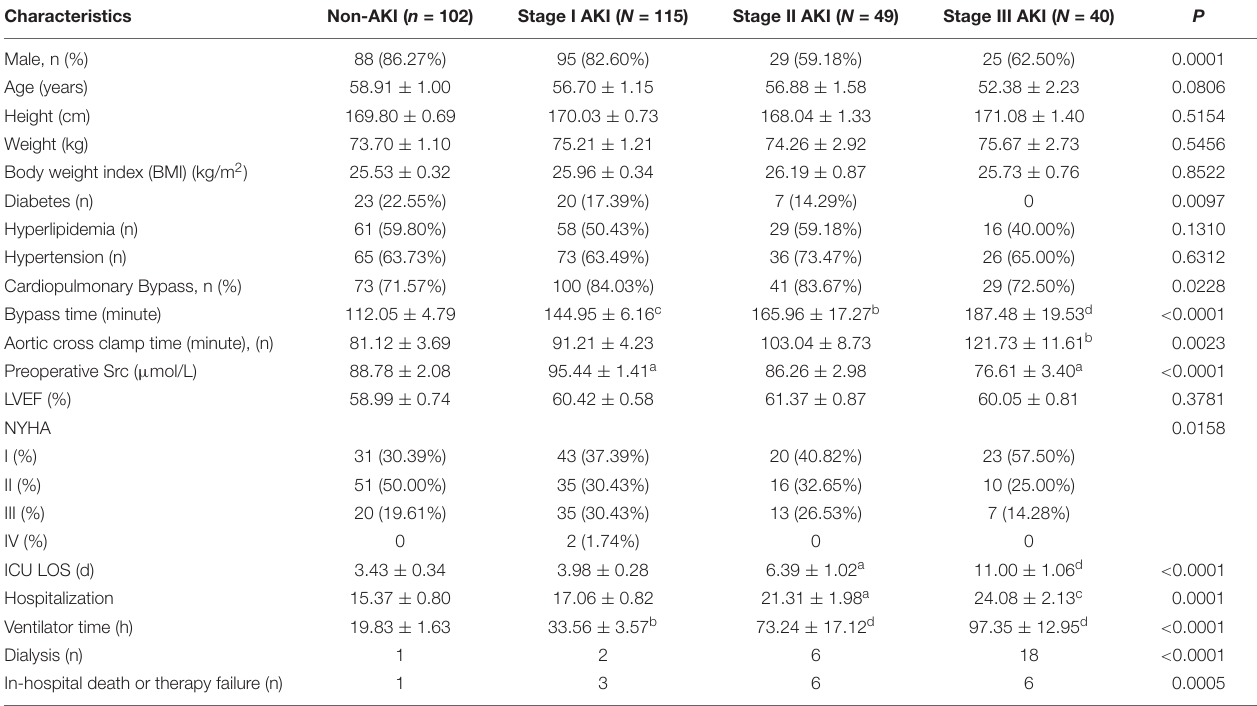
TABLE 2 | Baseline characteristics of patients with non-AKI and stage I, II, III AKI, respectively ( N = 306). Characteristics